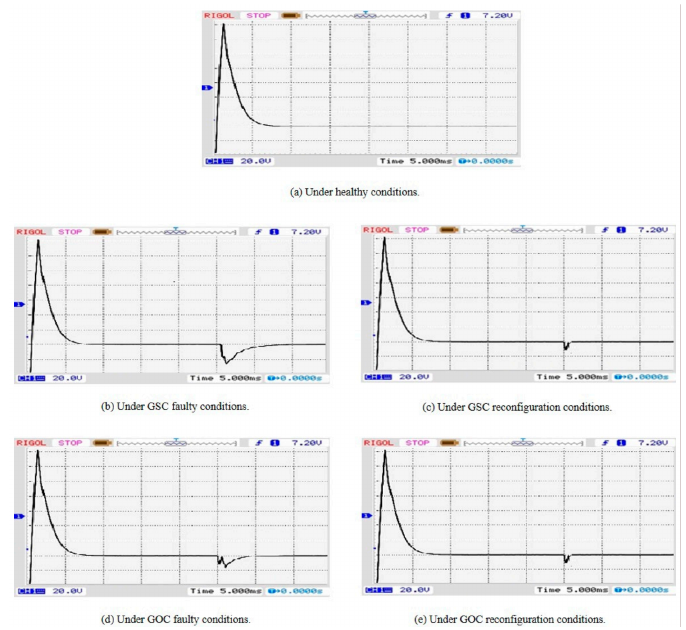
Figure 14. Electromagnetic torque of the induction motor under healthy, faulty and reconfigura- tion